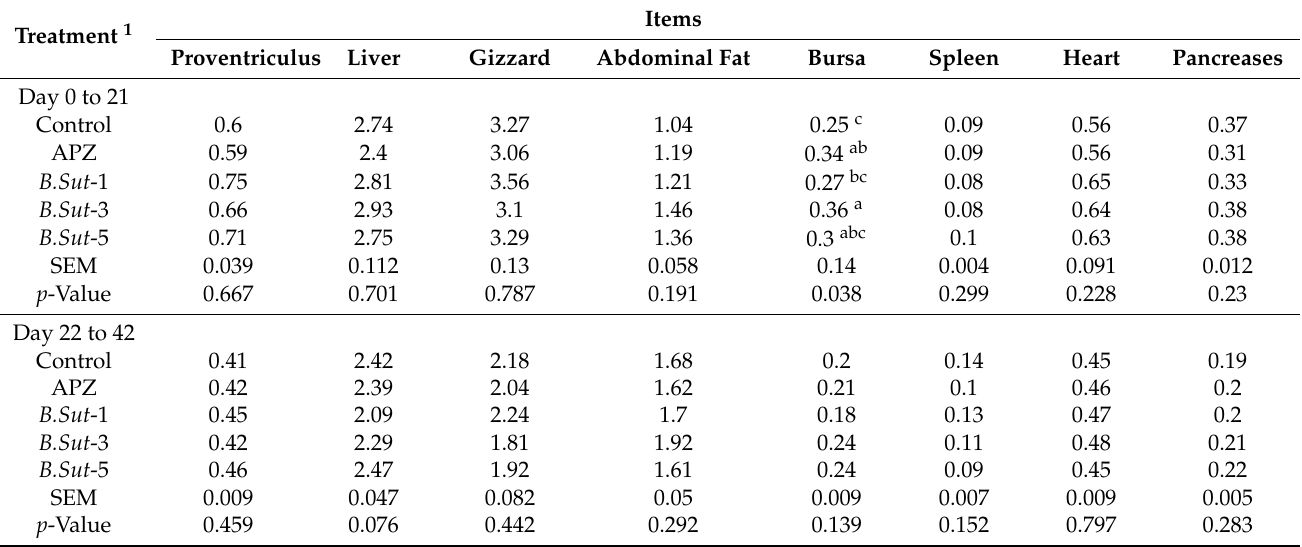
Table 2. Effect of the addition of Bacillus subtilis into broiler diets on broilers’ relative organ weight at 21st and 42nd days of age.